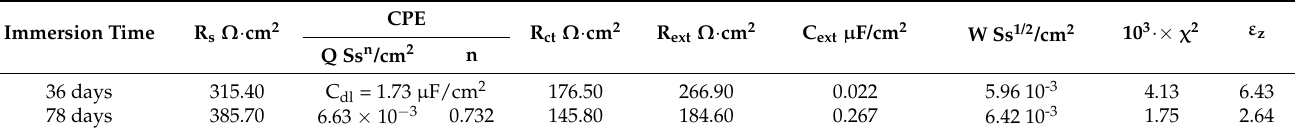
Figure 17. SEM microphotographs for the PPS sample maintained for 78 days in seawater ( a ) 100×, ( b ) 1000×, and ( c ) 5000×. Table 7. Equivalent circuit element values for PPS immersed 36 and 78 days in BSW. Immersion